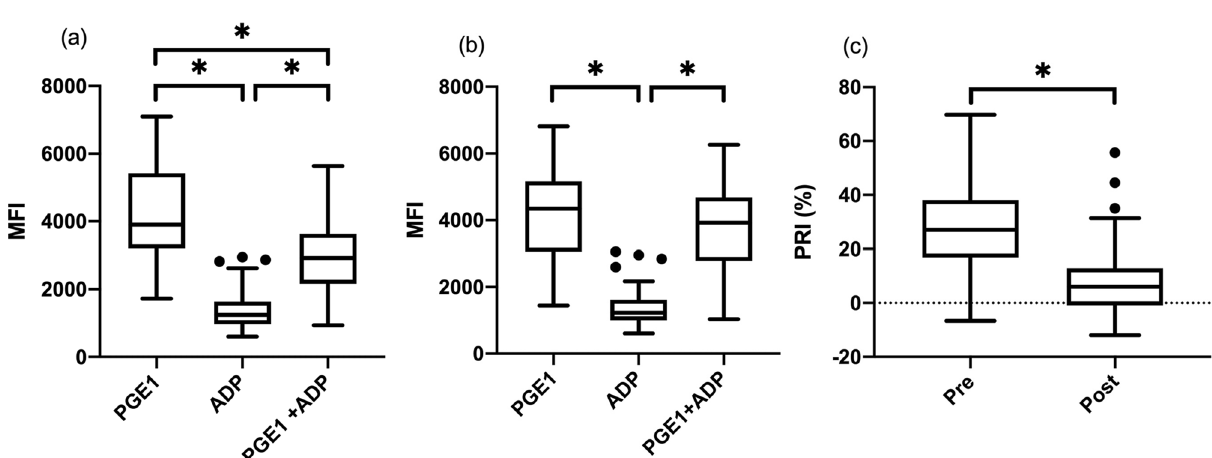
Figure 2. Flow cytometric analysis of intraplatelet P-VASP ( a ) before clopidogrel therapy and ( b ) after clopidogrel therapy in the presence of PGE 1 , ADP stimulation, or a combination of PGE 1 and ADP. Note there was a significant difference between the mean fluorescence intensity (MFI) with PGE 1 and PGE 1 in the presence of ADP stimulation before clopidogrel therapy, but no significant difference was found after clopidogrel therapy. ( c ) Platelet reactivity index (PRI) was calculated and compared before (pre) and after (post) clopidogrel therapy. The horizontal line represents the median, the box the 25th and 75th percentile, the whiskers the 1.5 times interquartile range, and the points outside the whiskers are outliers. * P <